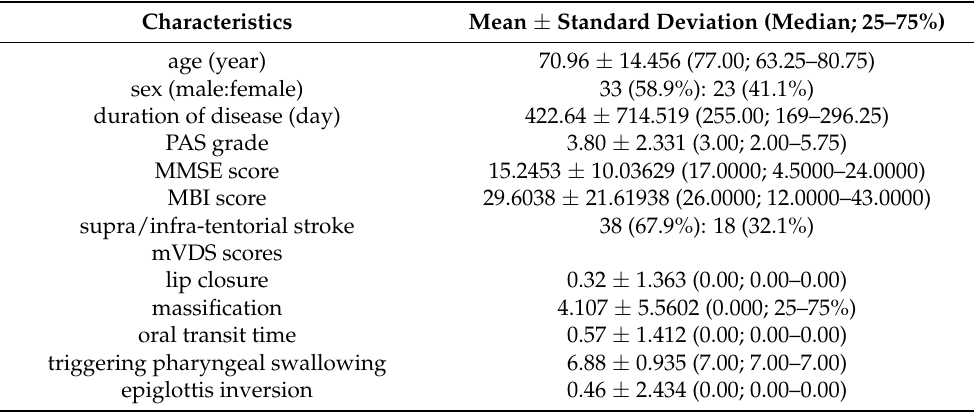
Table 2. Characteristics of stroke patients with dysphagia in the present